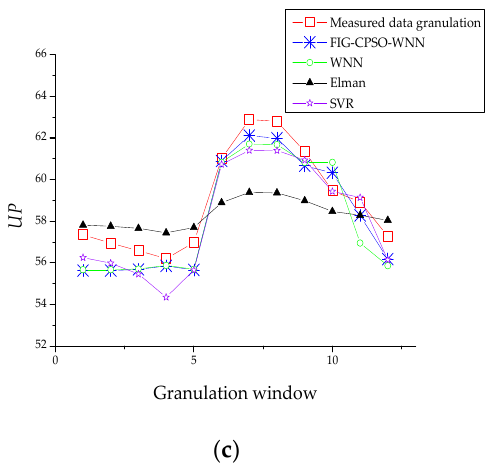
Figure 7. ( a ) Comparison of LOW predictions; ( b ) comparison of R predictions; ( c ) comparison of UP predictions. Table 3. Performance evaluation of three models.